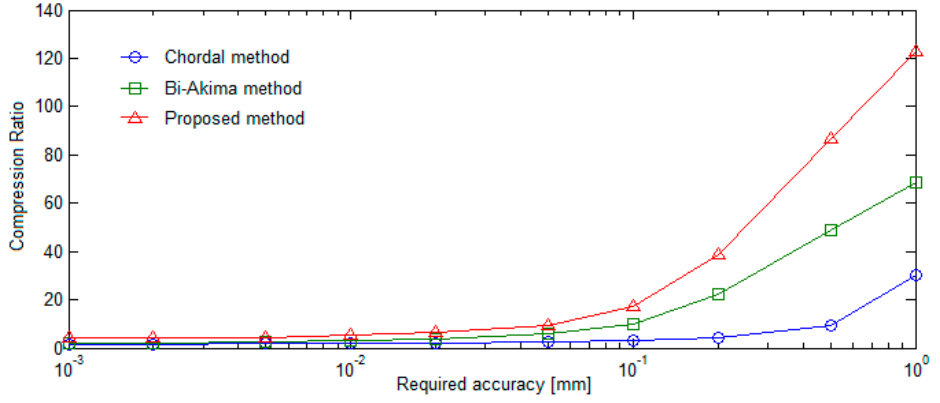
Figure 7. Data compression ratios under different required accuracies.